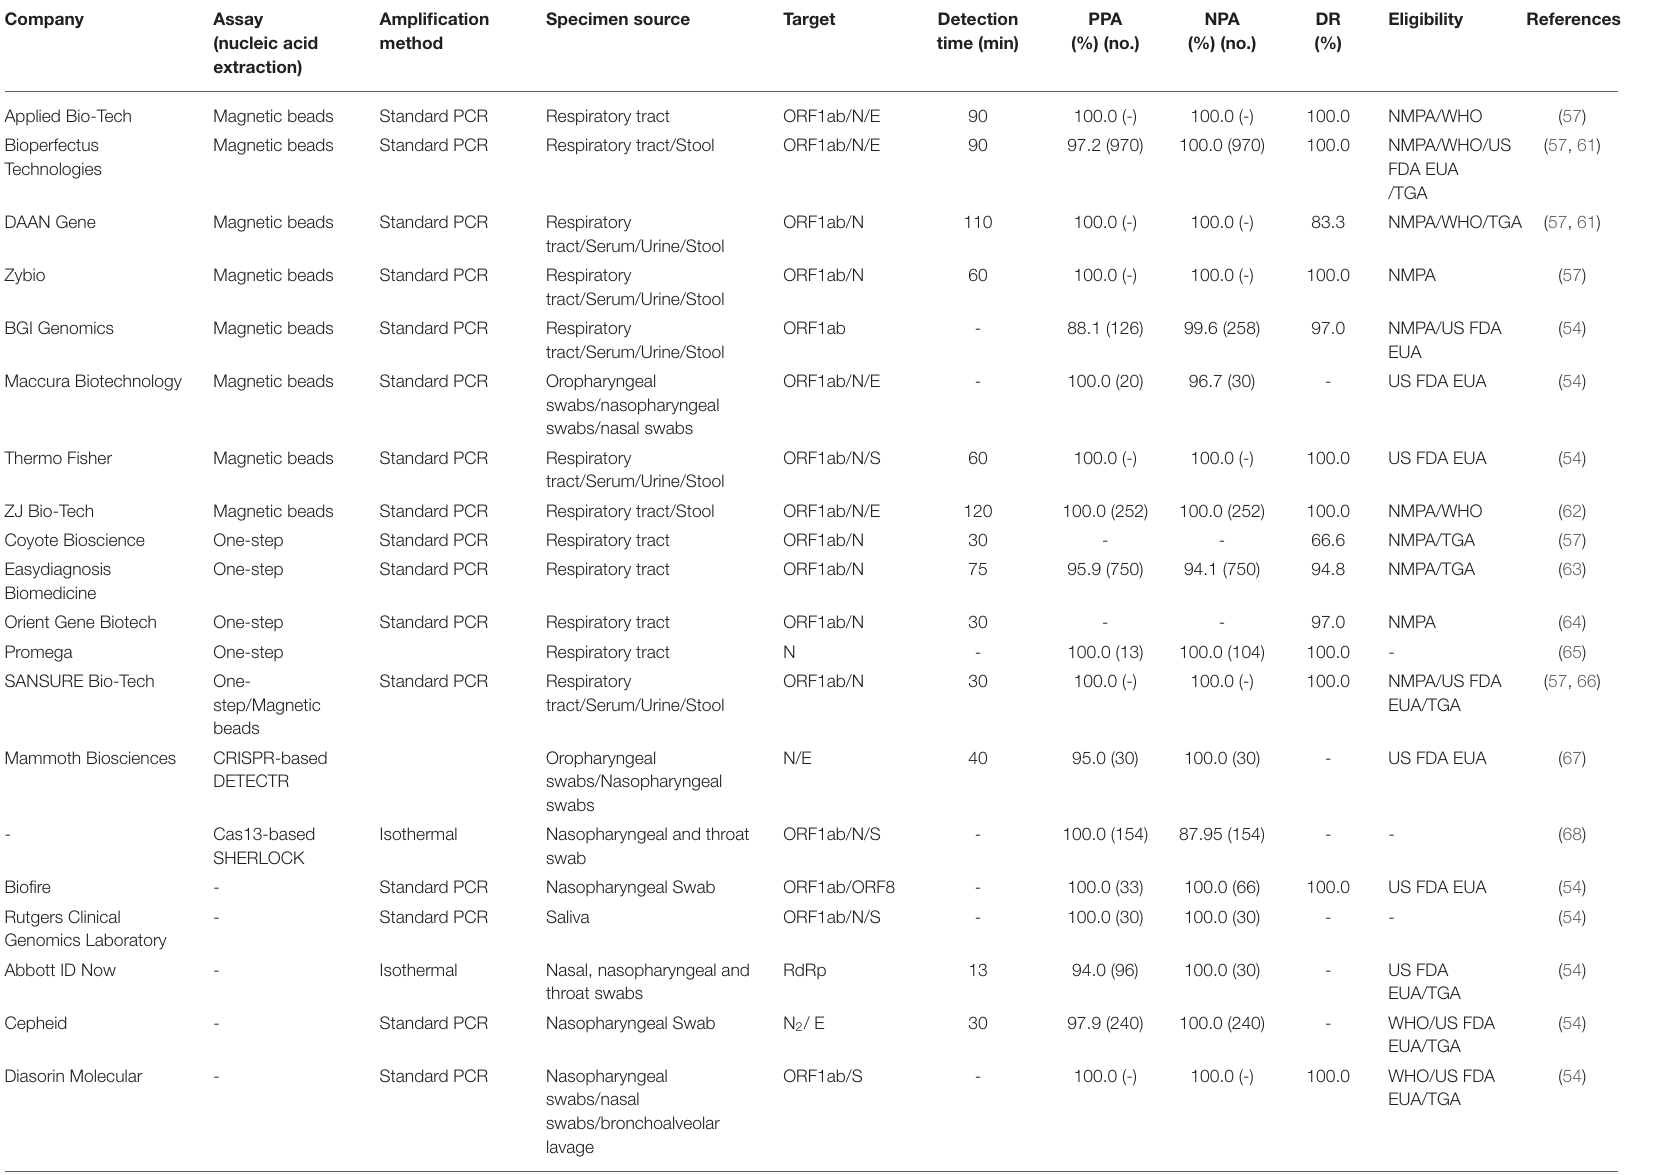
TABLE 2 | Detection of SARS-CoV-2 nucleic acid by molecular technology methods.